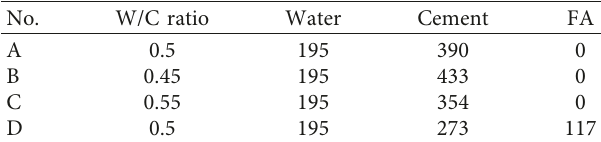
Table 3: Mix proportions of